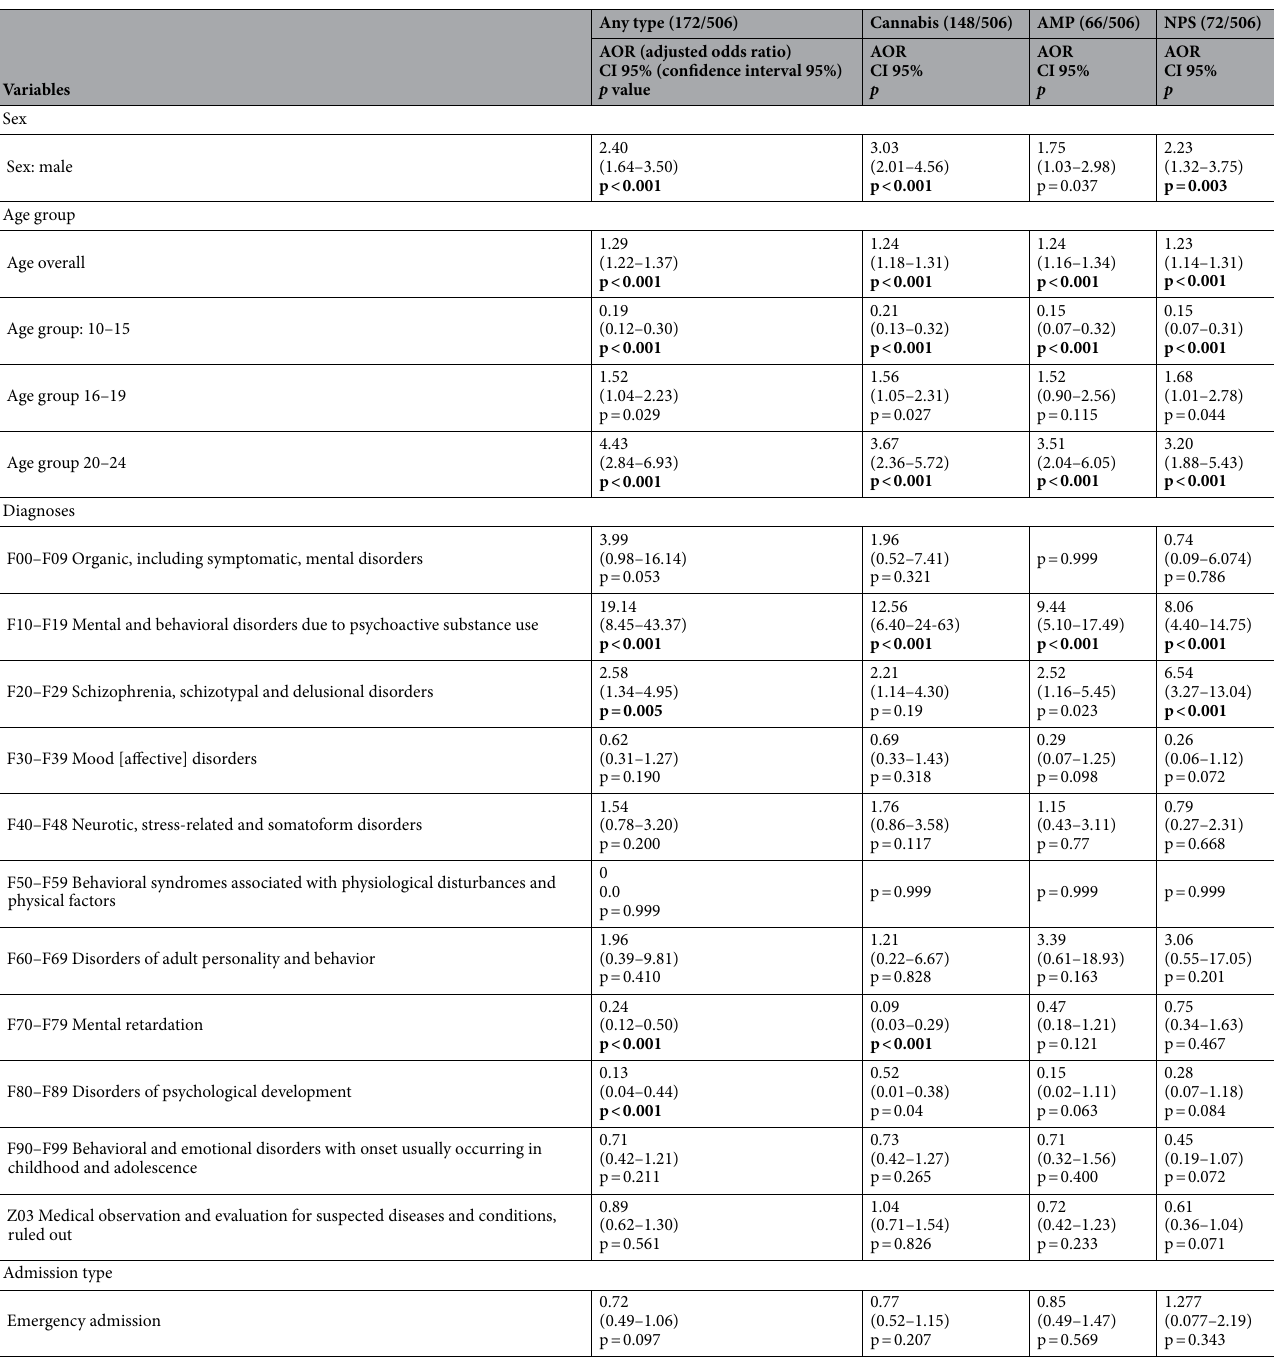
Table 6. Results of bivariate (single) logistic regression. Significant values are in